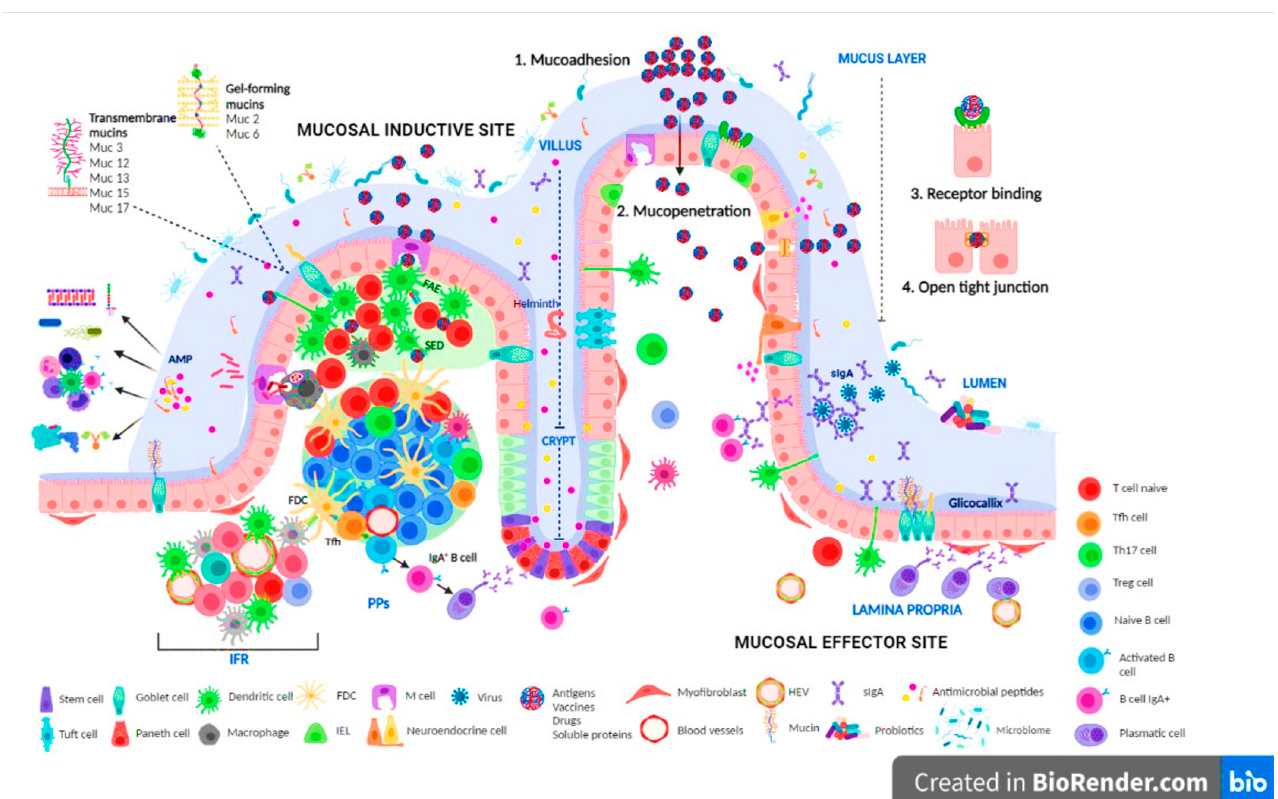
Figure 1. Components of gut-associated lymphoid tissues. The intestinal epithelium comprises multiple cell types derived from intestinal stem cells (IECs), including absorptive enterocytes, Paneth cells, goblet cells, tuft cells, and enteroendocrine cells. The IECs maintain gut homeostasis by synthesizing and secreting mucins, antimicrobial peptides, hormones, and soluble proteins. Furthermore, the IECs participate in the recognition of microorganisms via PPRs. The inner mucus layer or glycocalyx that lines the intestinal epithelium contains many antimicrobial peptides (AMPs) and IgA, both with effector functions. The outer mucus layer is also colonized by commensal microbiota. AMPs bind to glycosylated proteins, neutralize bacterial toxins, participate in the recruitment of effectors cells, and directly kill bacteria. Antigen uptake can occur by M-cell-mediated transcytosis, via macrophage/dendritic cells extending transepithelial dendrites into the gut lumen, paracellular pathway, or through goblet-cells-associated antigen passages. The passage of the particles is further facilitated by mucoadhesion and mucopenetration phenomena. In gut-associated lymphoid tissues, antigens are presented to naive T and B cells with subsequent antigen-specific immune responses. PPs are mucosa-inductive sites for immune responses in the gastrointestinal tract, while the lamina propria and epithelial compartment constitute effector sites. FAE, follicle associated epithelial; SED, subepithelial dome; PPs, Peyer’s patches; IFR, interfollicular regions; FDC, follicular dendritic cells; Tfh, T follicular helper